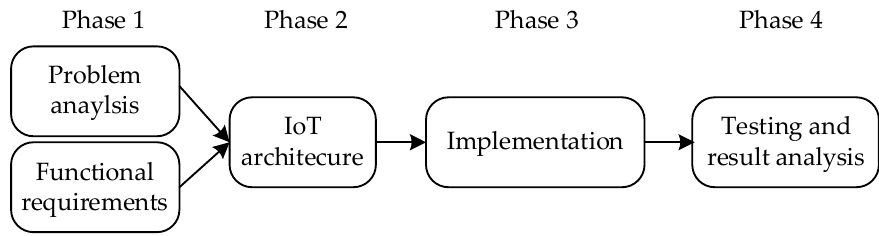
Figure 1. Development phases of the proposed IoT system.